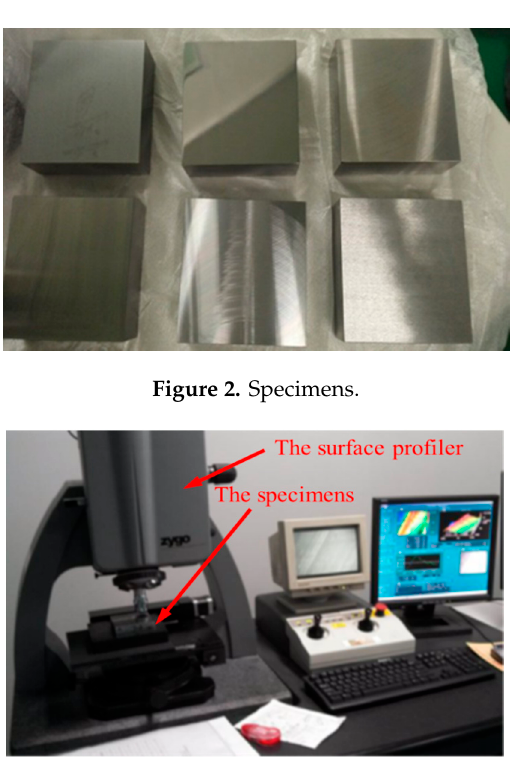
Figure 3. The test instrument.